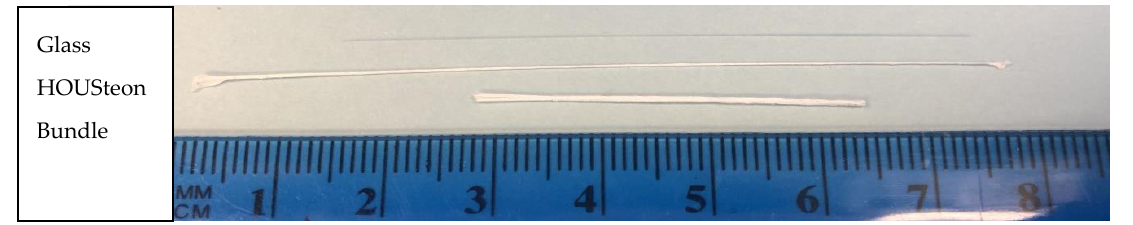
Figure 2. Macroscopic image of a glass fiber, HOUSTeon, and HOUSteon bundle.